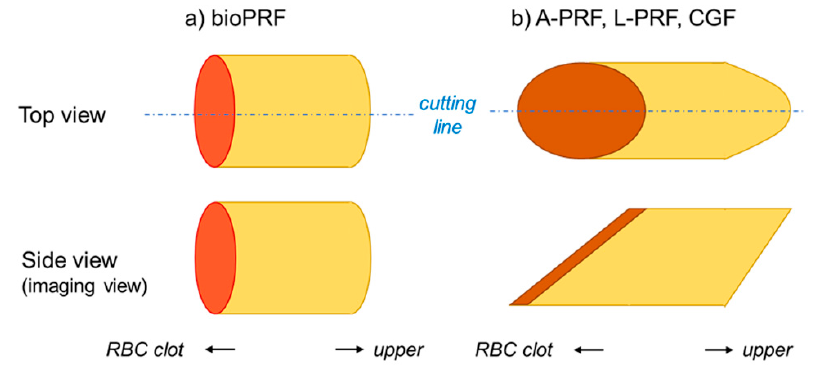
Figure 7. The differences in the shapes of individual platelet-rich fibrin (PRF) matrices. The shape of bio-PRF ( a ) is distinguishable from those of other PRF matrices ( b ). The “cutting line” represents the center line of PRF matrices for the sagittal section.